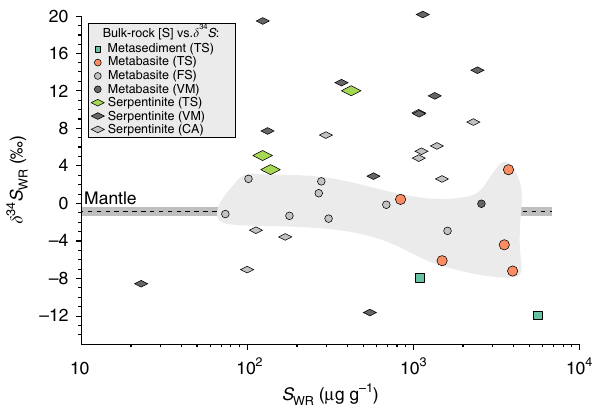
Fig. 3 Whole-rock (WR) sulfur concentrations and isotope values of HP metasediments, blueschists/eclogites, and serpentinites worldwide. Errors (2 σ ) of δ 34 S WR and S WR calculated from measurement reproducibility are less than the symbol size. Sulfur isotope values of HP Tianshan (TS) rocks are from this study, Franciscan (FS) eclogites and blueschists from ref. 10 , high-pressure serpentinites of the Voltri Massif (VM, Italy) from refs. 47,48 , high-pressure serpentinites of the Cerro del Almirez (CA, Spain) from ref. 21 , and the mantle value ( − 0.91±0.50 ‰ ) from ref. 45 . The shaded area indicates δ 34 S range of metabasites, which is comparable to the mantle value. Source data are provided in Supplementary